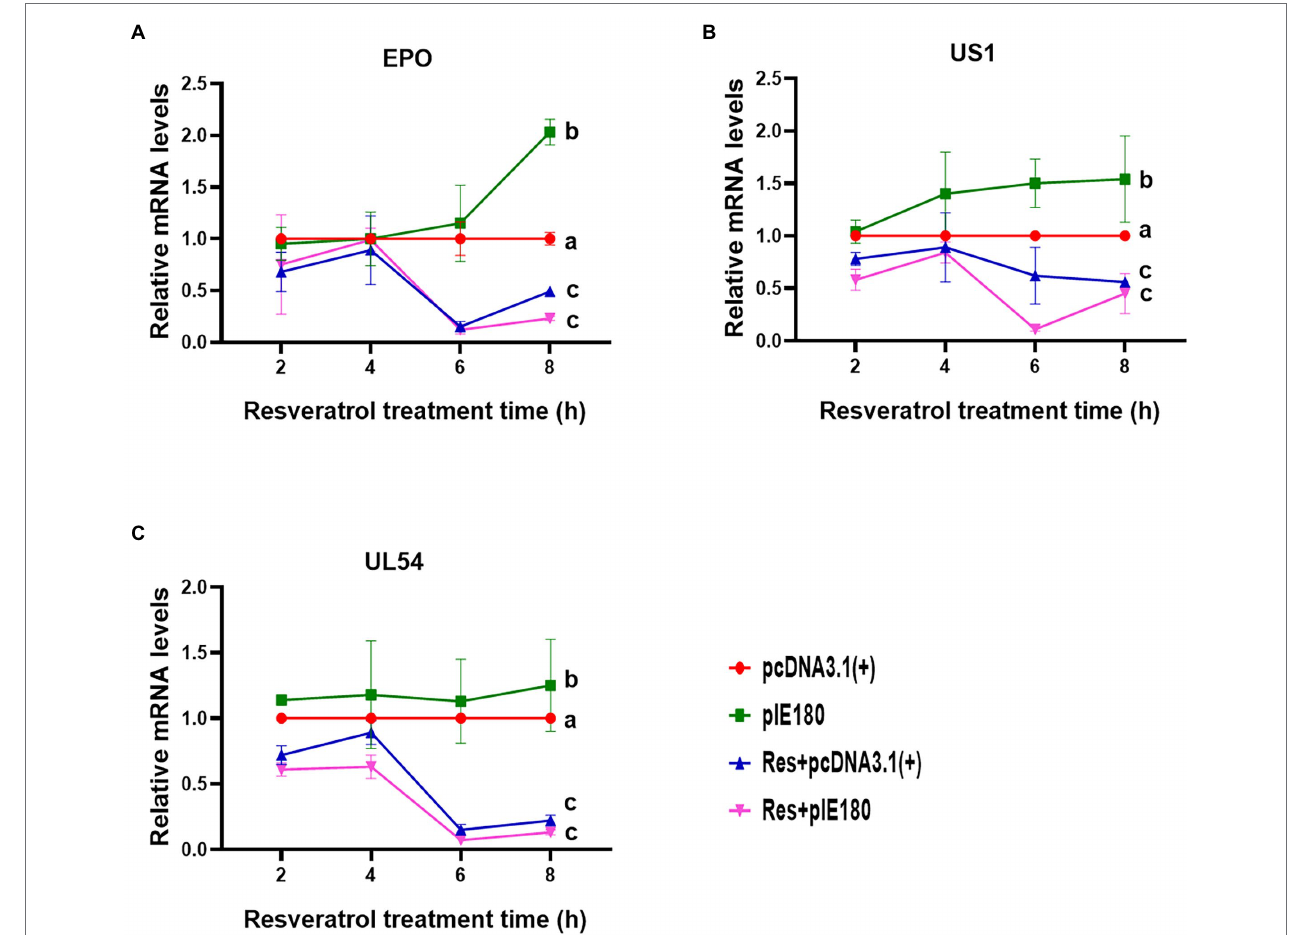
FIGURE 5 | Effects of Res on early gene expressions after transfection with pIE180. (A) Effects of Res on early gene (EPO) expressions after transfection with pIE180. (B) Effects of Res on early gene (US1) expressions after transfection with pIE180. (C) Effects of Res on early gene (UL54) expressions after transfection with